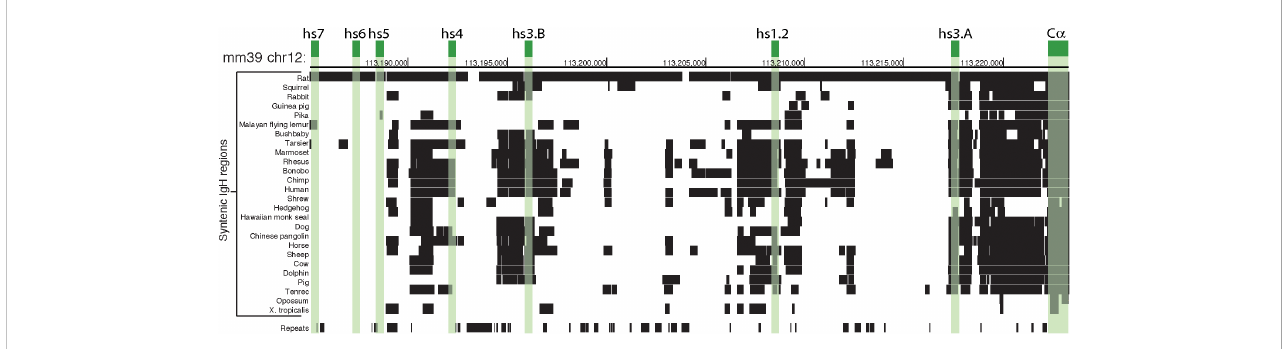
FIGURE 5 Mouse 3 ’ RR and syntenic region in Vertebrata. The schematic is focused on a comparative analysis of the 3 ’ RR and a constant region (C a ) within the IgH gene locus. Green boxes highlight the position of the 7 enhancers and C a in the murine chromosome 12 (mm39 genome assembly). The rows below show alignments of mm39 to other genomes using a gap scoring system (see UCSC Net track for details); detected orthologous regions are indicated by black boxes. Three of the enhancers (i.e. hs5, hs6, and hs7) are speci fi c to mouse and rat, while the other enhancers (i.e. hs3A, hs1.2, and hs3B) appear shared among more species, almost to the same level as C a . The ‘ Repeats ’ row indicates segments of the murine IgH region that are detected as ‘ repeats ’ (e.g. SINEs, LINEs, satellites) by RepeatMasker software (https://www.repeatmasker.org) and could be ignored in a synteny comparisons because of their